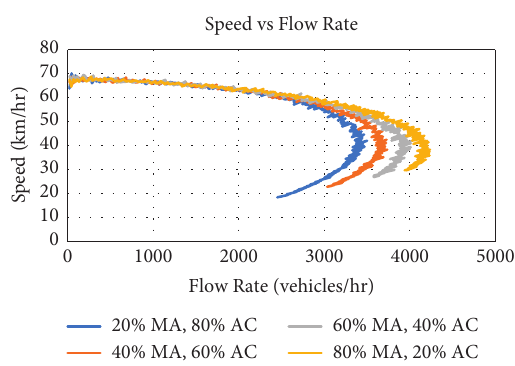
Figure 24: Speed vs. flow rate fundamental diagrams for different compositions of MA and